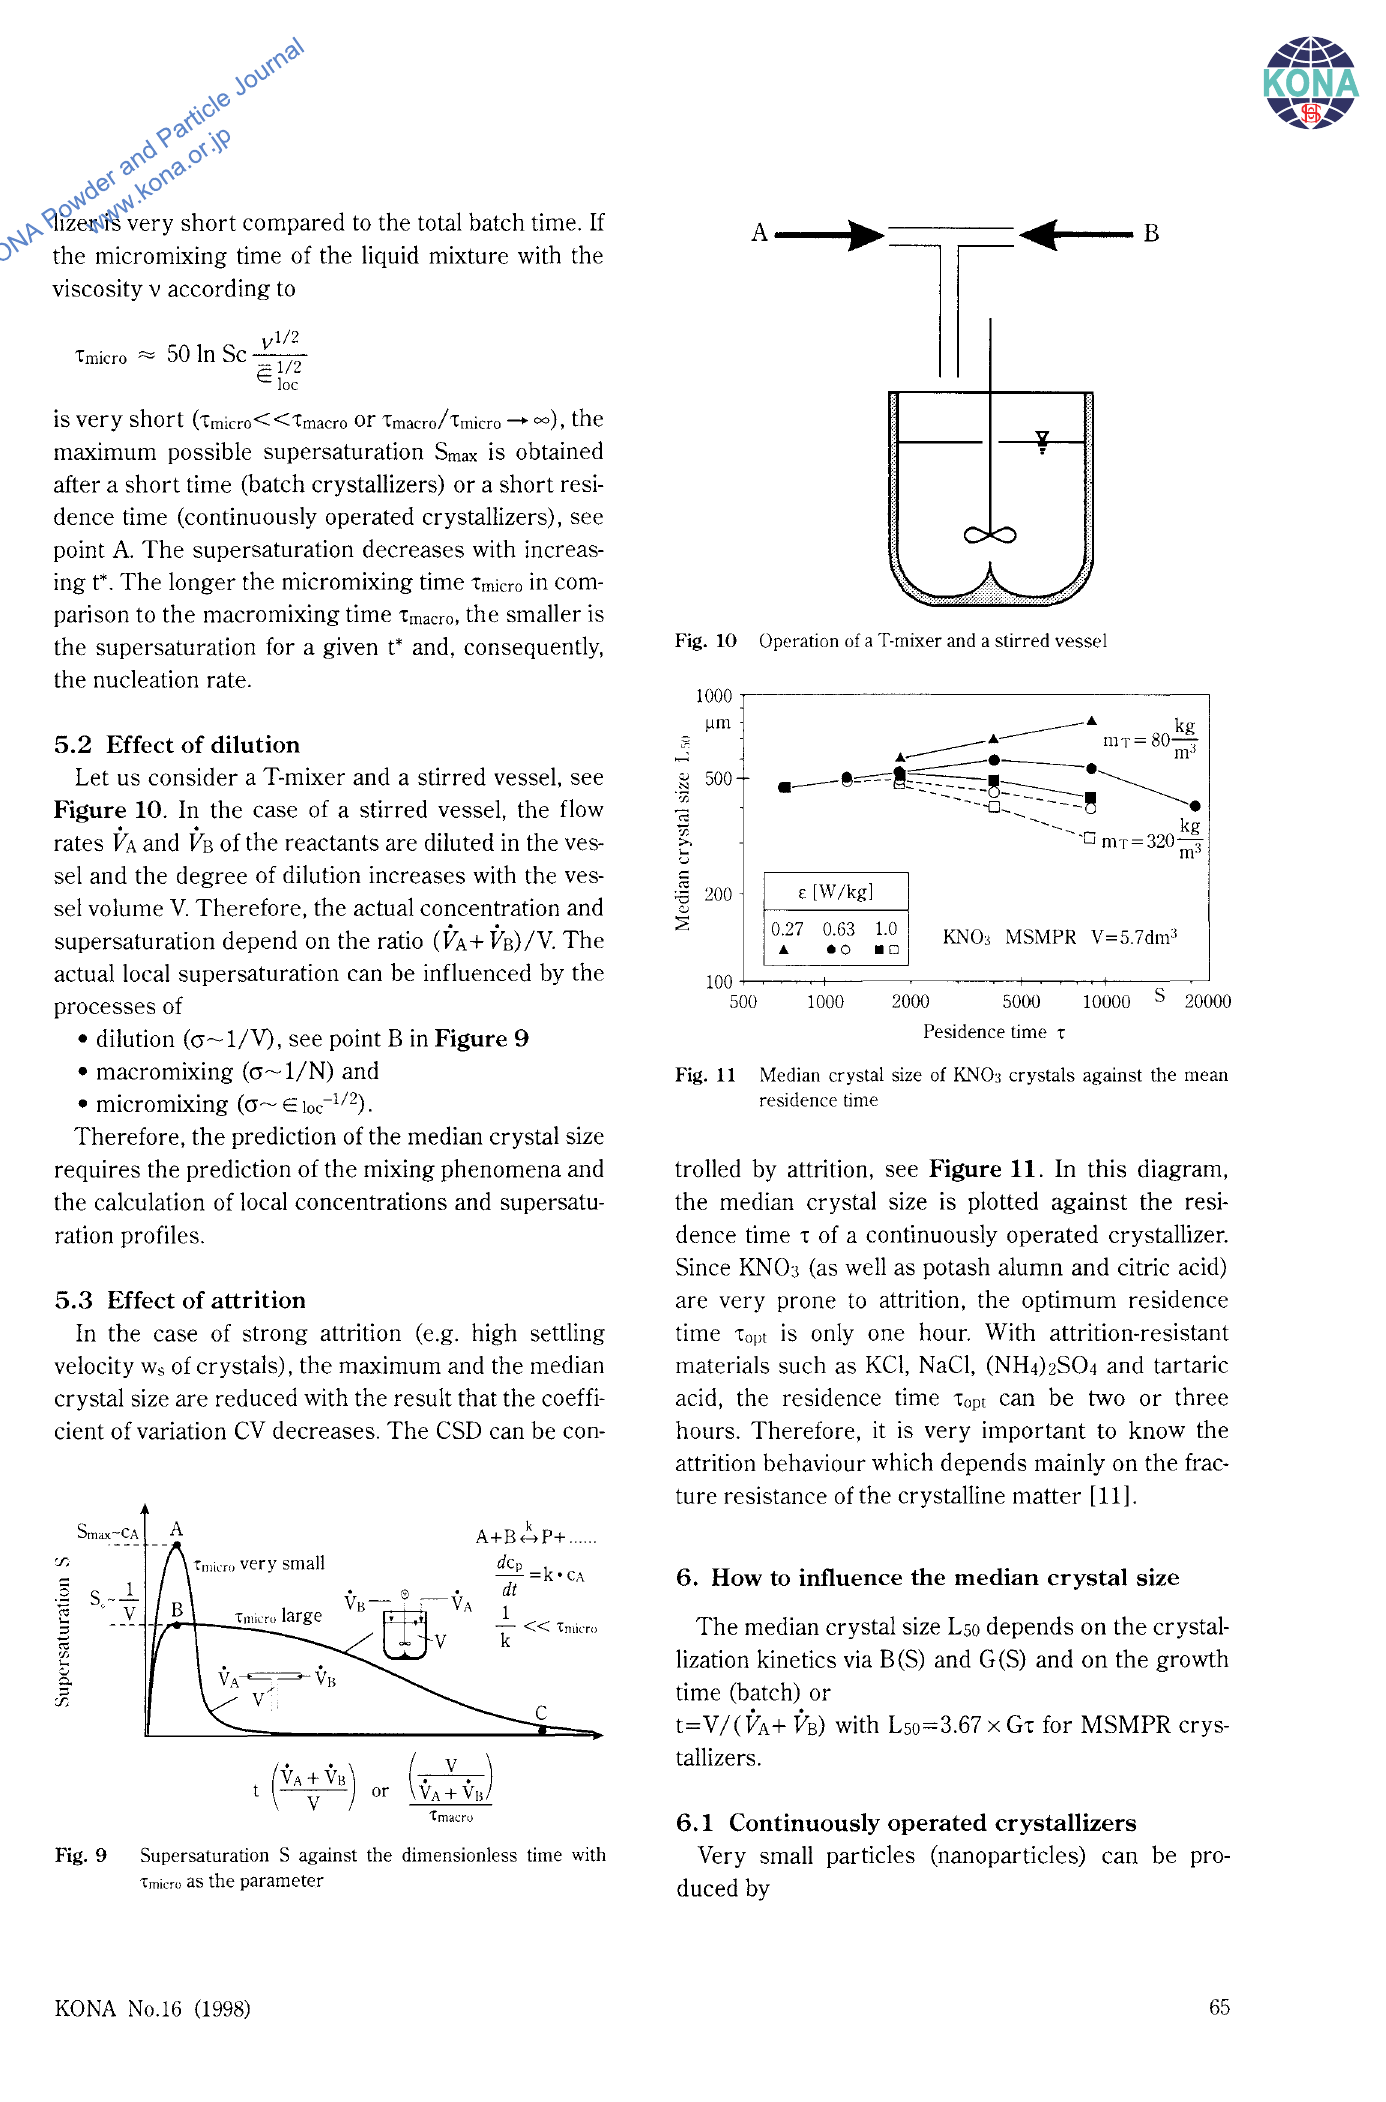
Supersaturation S against the dimensionless time with Trnicro as the parameter